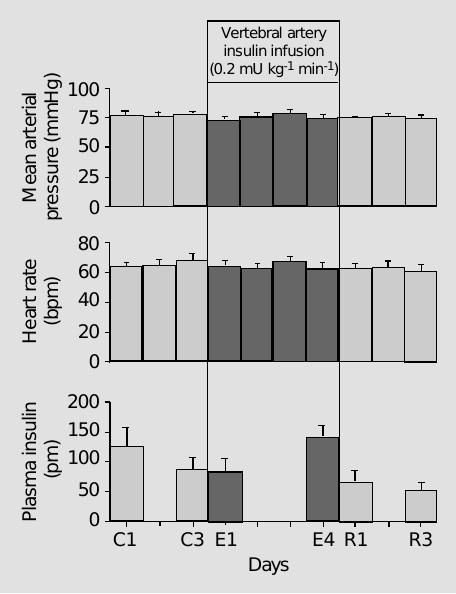
Figure 5 - Effects of 4 days of vertebral artery insulin infusion on mean arterial pressure, car- diac output, and total peripheral vascular resistance in dogs. C, Control; E, experimental; R, re- covery. (Redrawn from Ref.